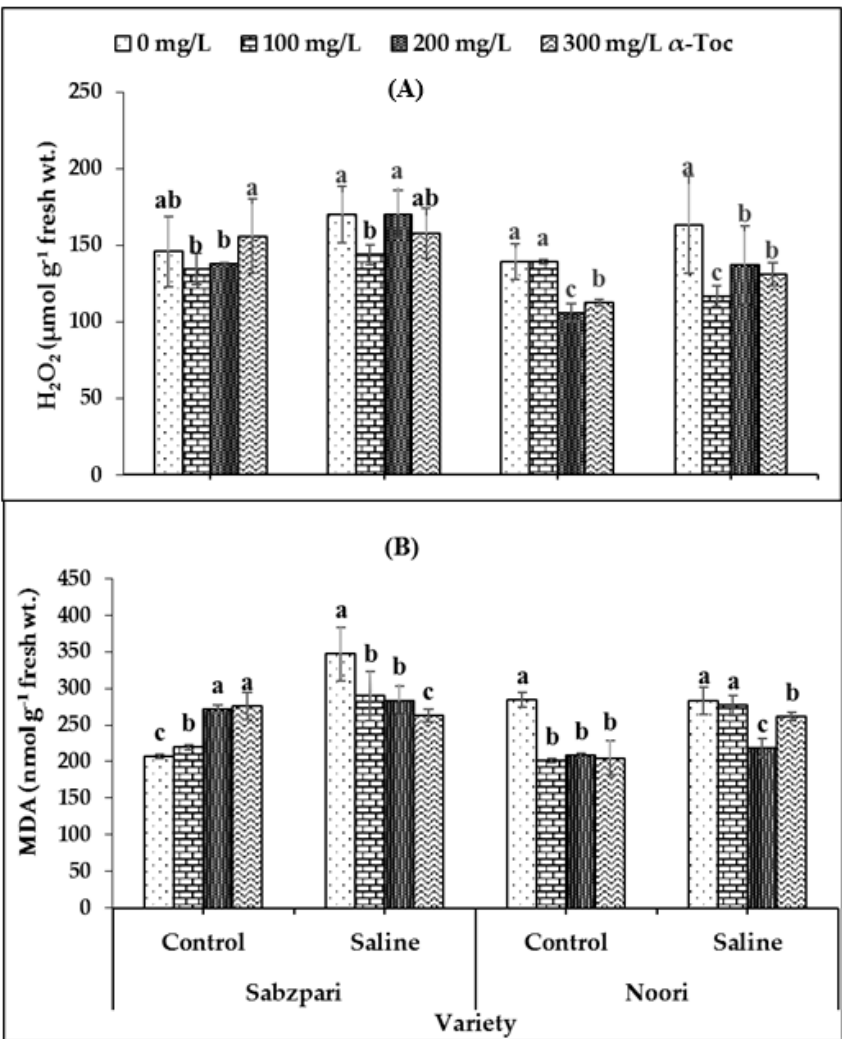
Figure 5. Effect of different levels of α -Toc under saline and non-saline conditions on ( A ) hydrogen peroxide (H 2 O 2 ) and ( B ) malondialdehyde (MDA) content of okra varieties. Values represent means ± S.D. Significant differences among row spacing were measured by the least significant difference (LSD) at p > 0.05 and indicated by different letters. S.D. stands for standard deviation.